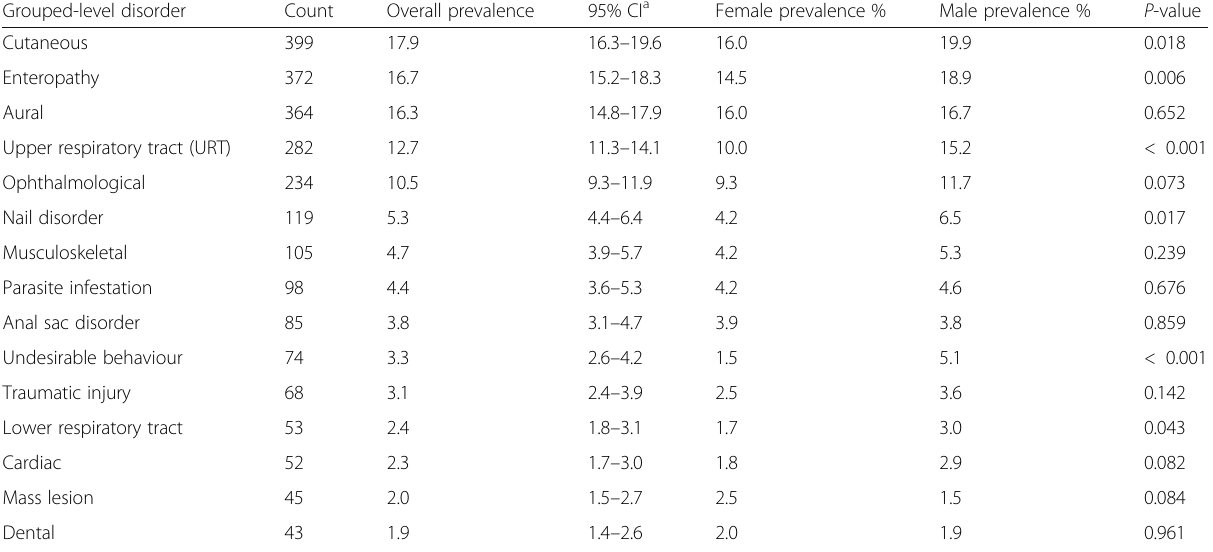
Table 5 Prevalence of the most common grouped-level disorders recorded in French Bulldogs ( n = 2228) attending UK primary-care veterinary practices participating in the VetCompass ™ Programme from January 1st, 2013 to December 31st, 2013 Grouped-level